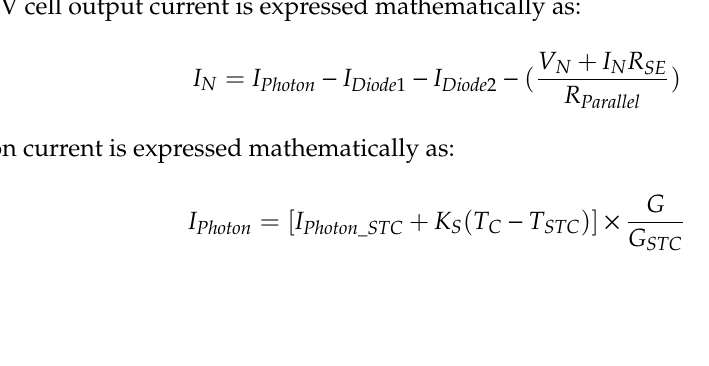
Figure 6. Double diode PV model.